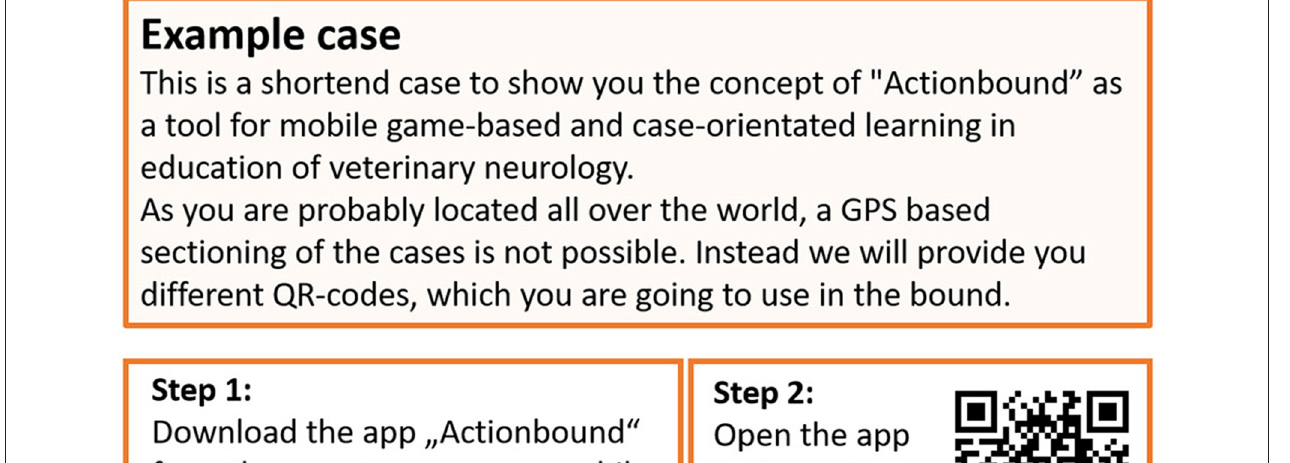
FIGURE 3 | Example case. Follow the instructions to play an example case, which is a short adapted English version of an original bound (paraparetic Boxer). GPS, global positioning system; QR code, quick response code.